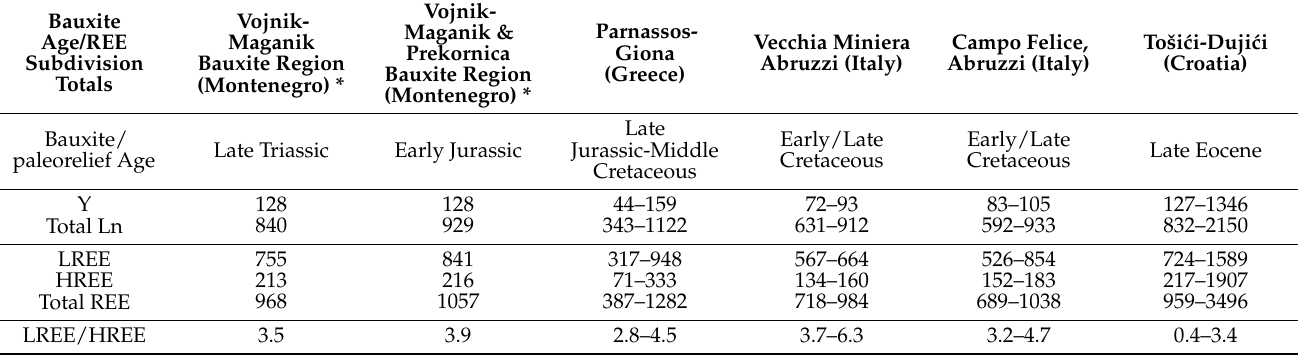
Table 3. Comparison of REE abundances in the Toši´ci-Duji´ci deposit with REE content in selected karst bauxite deposits of the Mediterranean area (data for Montenegro bauxites from [34], for Abruzzi bauxites in Italy from [32], and for Parnassos-Giona bauxites in Greece from [3,4]) (Ln = lanthanides). Bauxite